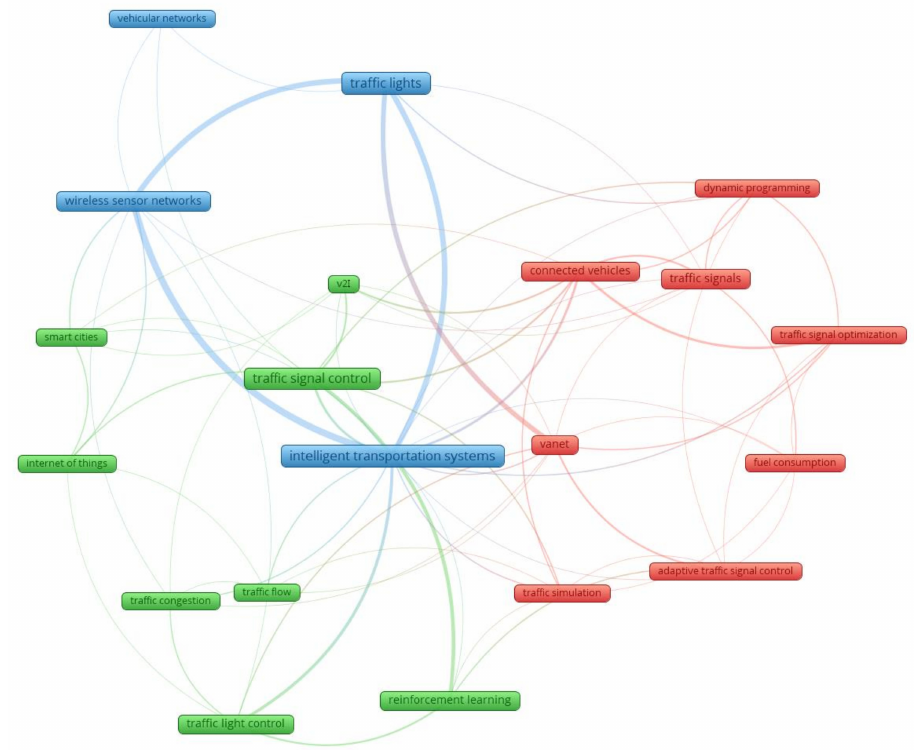
Figure 3. Keywords topic visualization analysis—concurrence